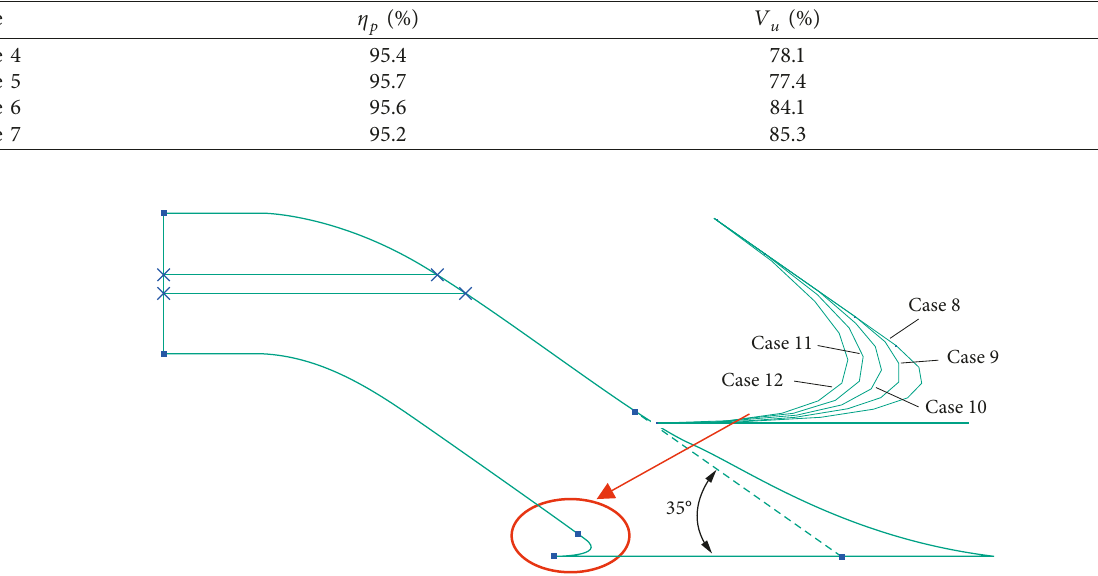
Figure 25: Sketch of the lip structure optimization